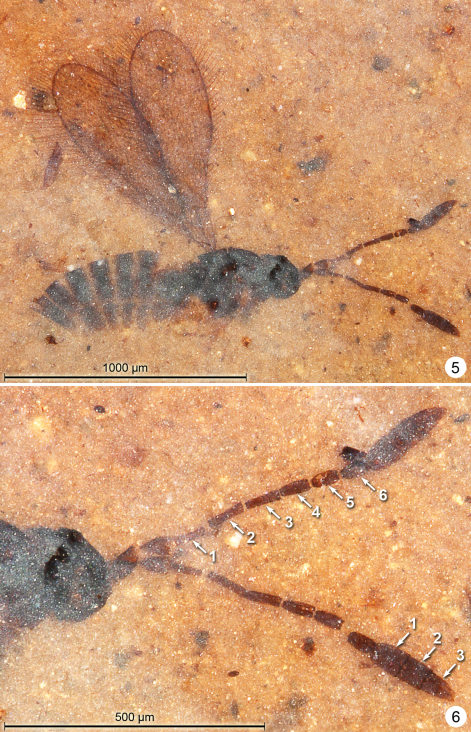
Eoeustochus borchersi, holotype 5 habitus lateral 6 head and antennae.